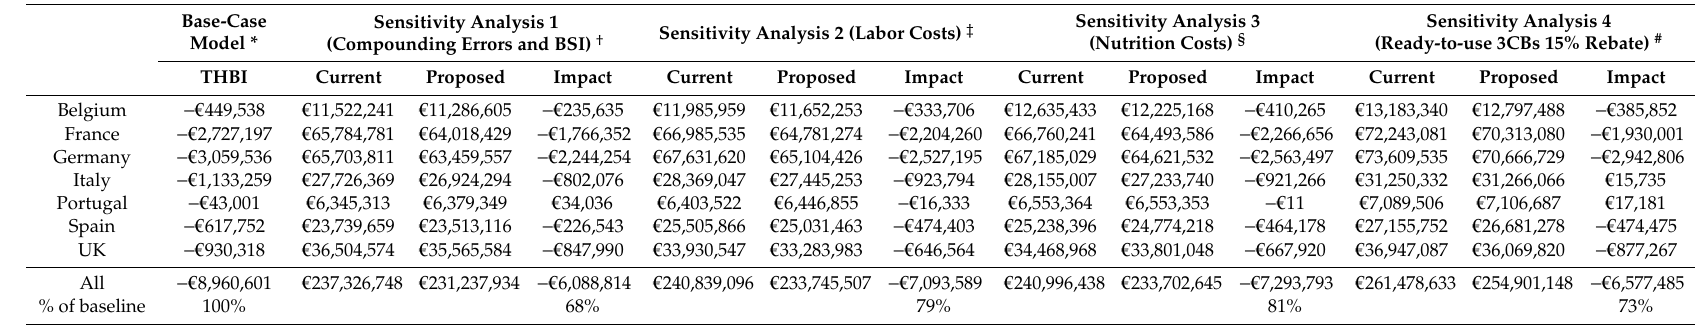
Table 5. Sensitivity